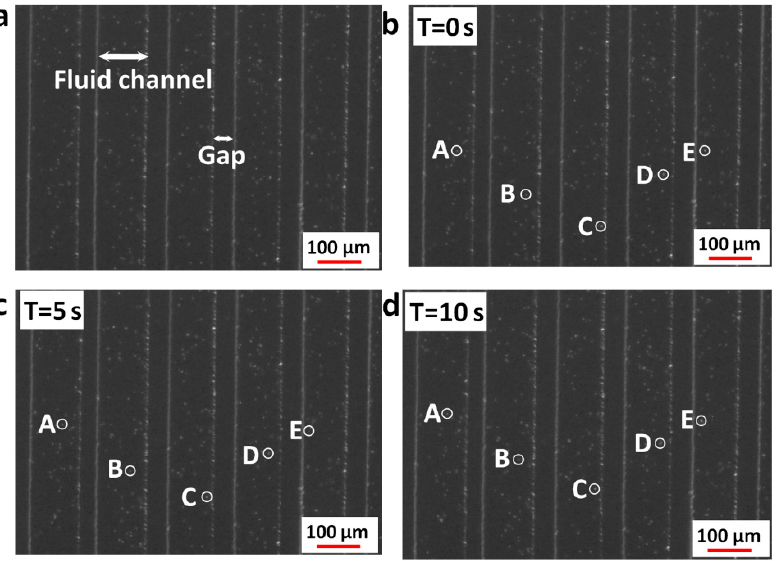
Figure 5. Sequential images of fluorescent particle movements of EOF. ( a ) Image instruction; ( b ) particle status at 0 s; ( c ) particle status at 5 s; ( d ) particle status at 10 s.